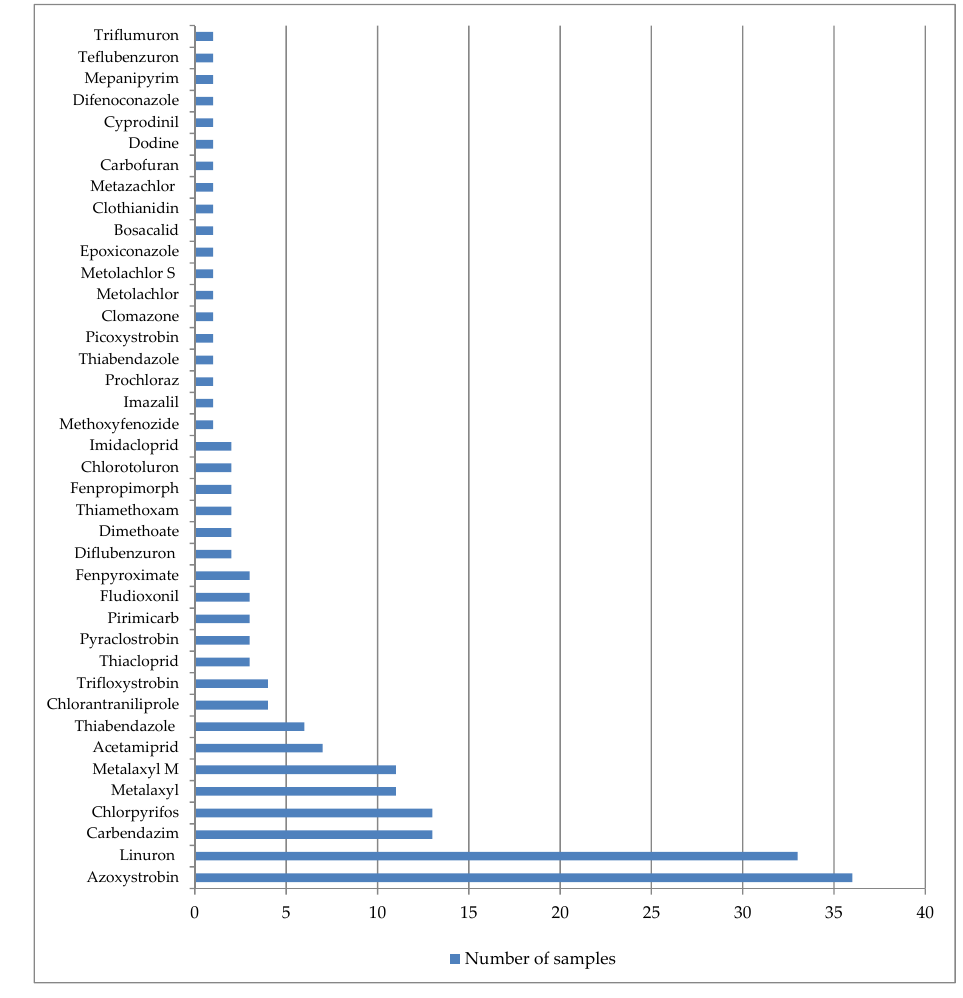
Figure 1. Pesticide occurrence frequency in analysed samples .